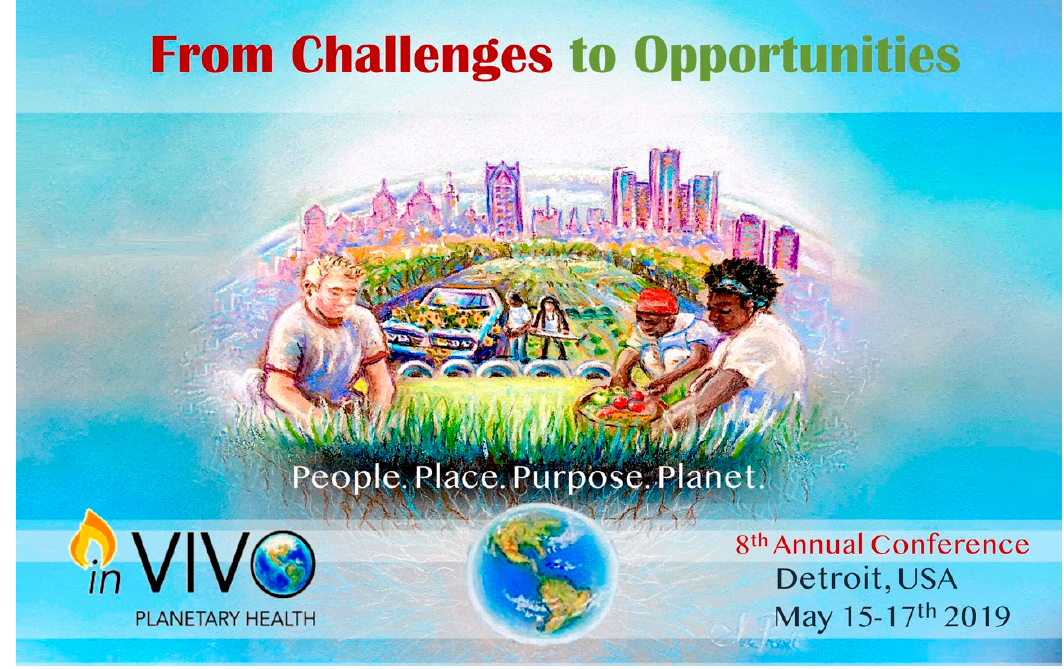
Figure 1. The theme of the 8th annual conference of inVIVO Planetary Health, held in Detroit, Michigan from 15–17 May, 2019 was “From Challenges, to Opportunities”.